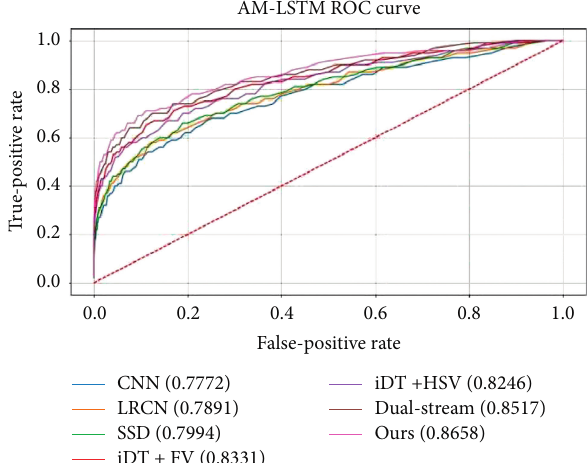
Figure 9: ROC curve of different methods.